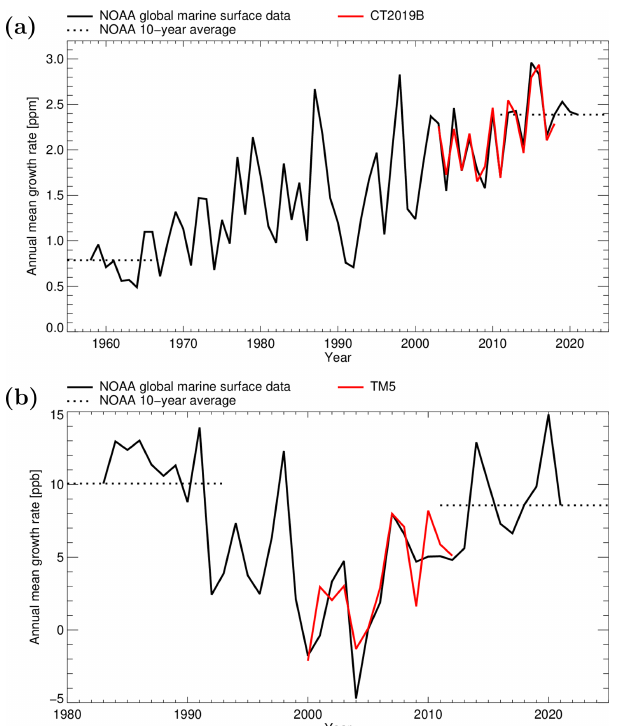
Figure A1. Global growth rates for CO 2 (a) and CH 4 (b)